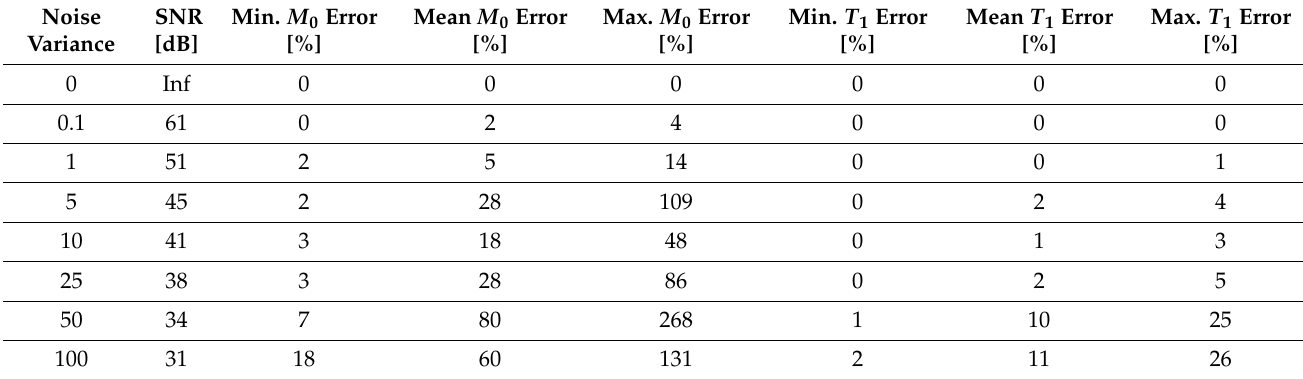
Table 2. Relative error of estimated coefficients—data with added noise.